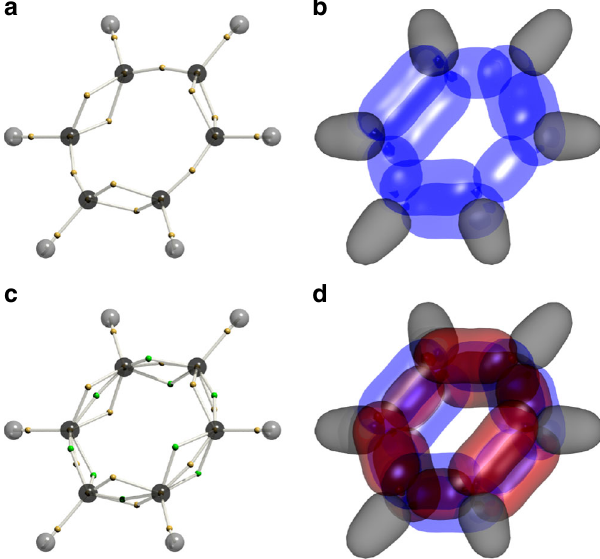
Fig. 1 DVMS structures for benzene. a Voronoi site for the RHF/6-31G(d) wavefunction. The electron positions of an arbitrary spin are shown as small yellow spheres. b Cross sections through the wavefunction around the Voronoi site in a C – C bonding electrons are shown as blue lobes. C – H bonds are shown in grey. c . Voronoi site showing staggered spins. The electron positions of each spin are respectively shown as small yellow and green spheres. d . Cross sections around the Voronoi site in c . The two spins of the C – C bonding electrons are shown in blue and red. C – H bonds are shown in grey.